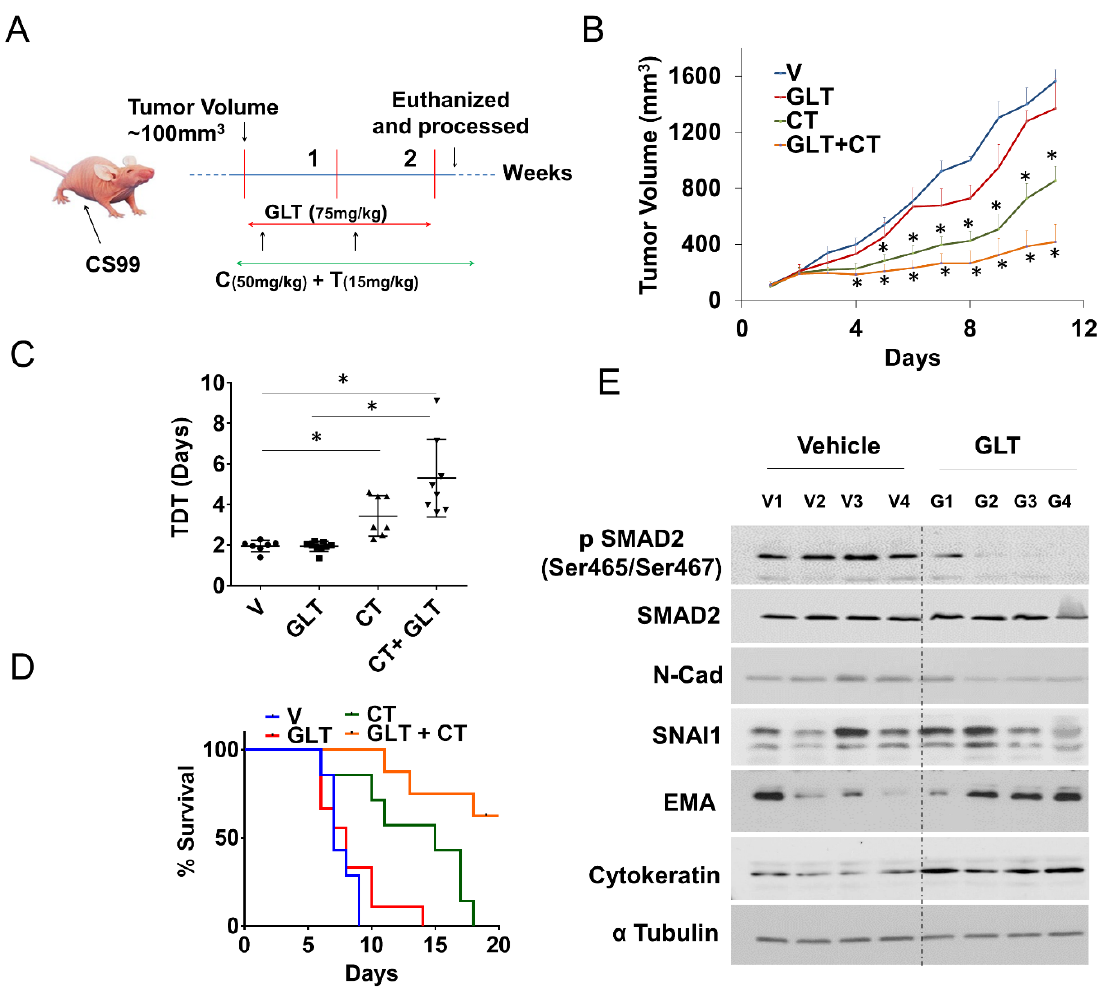
FIGURE 4: GLT sensitizes tumor cells to chemotherapy in a mouse model. (A) Female athymic nude mice were subcutaneously injected with CS-99 cells, once the tumor reached to ~100 mm 3 , tumor bearing mice were randomized into four groups (n = 7-10) and treated with either control vehicle (V), GLT, carboplatin & paclitaxel (CT), or GLT + CT. Treatment continued for two cycles (14 days), and mice were fol- lowed for survival. (B) Relative tumor volume normalized with V (vehicle) group. (C) Tumor doubling time (TDT) was calculated for each treatment groups according to Mehrara and colleagues [35]. Data are mean ± SD and *, P < 0.05 when comparing between indicated groups by one-way ANOVA (D) Percent survival was calculated by Kaplan – Meier method and P values determined by log-rank test based on the number of days the animals survived before the euthanization as per IACUC limits (humane endpoint). (E) Four tumor samples from vehicle treated control and GLT treated group were analyzed for the expression of TGFβ1 signaling and EMT markers using immunoblotting, alpha tubulin was used as loading control. Values are mean ±SD.